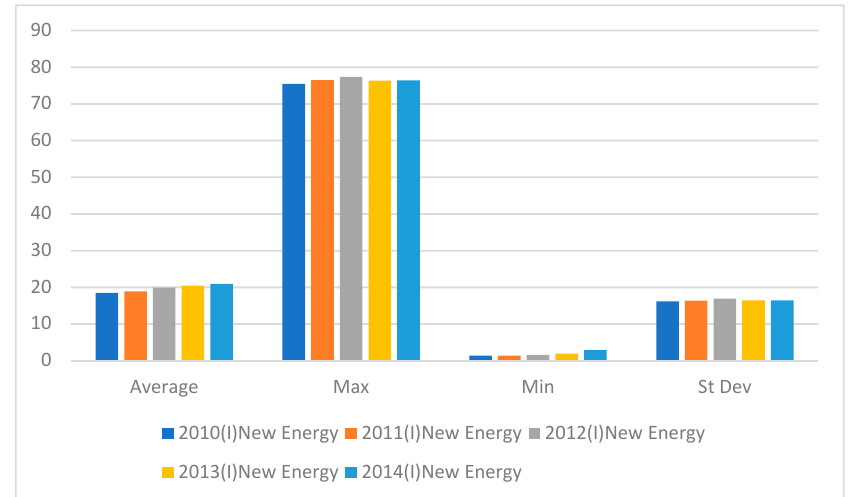
Figure 4. New Energy Input variables from 2010–2014.